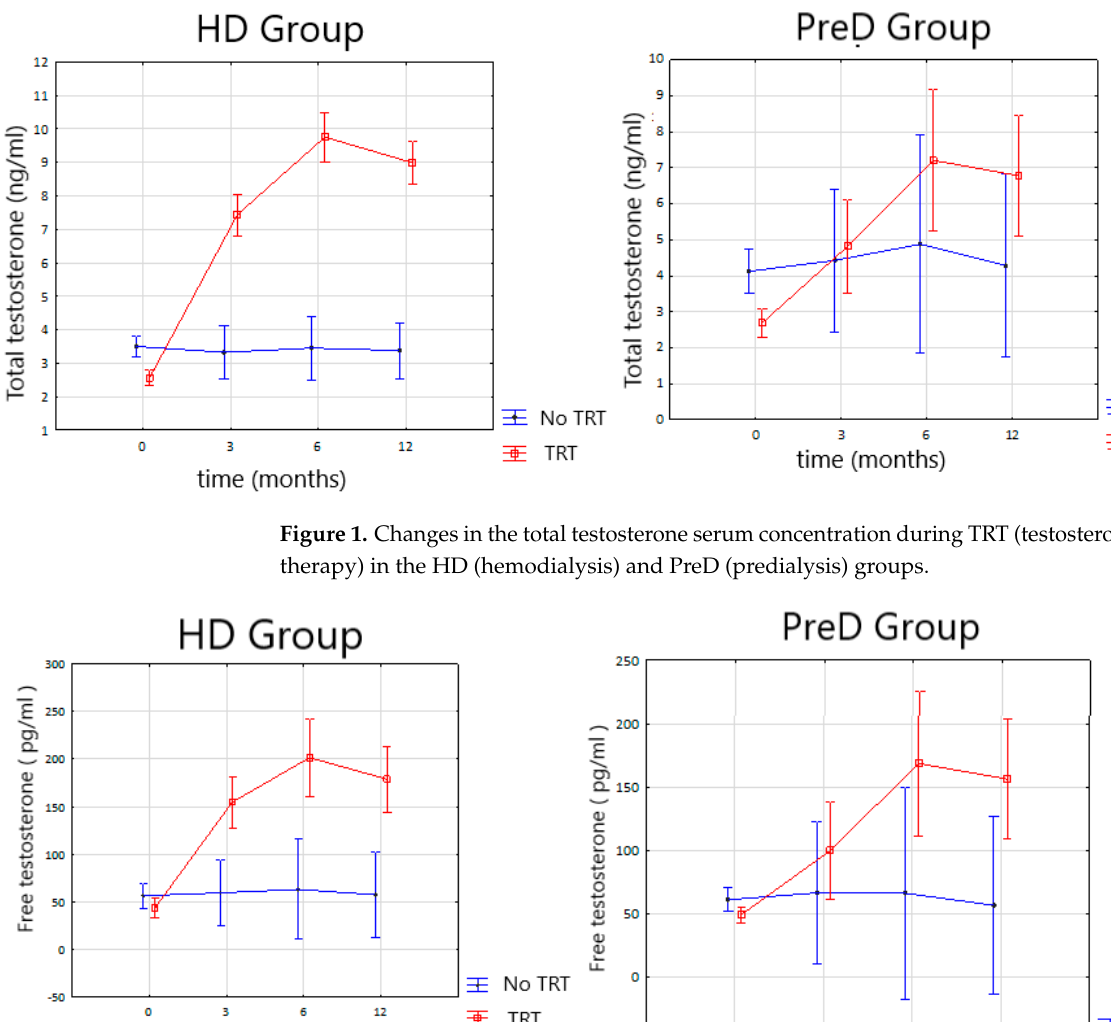
Table 2. Changes of the observed parameters during TRT.